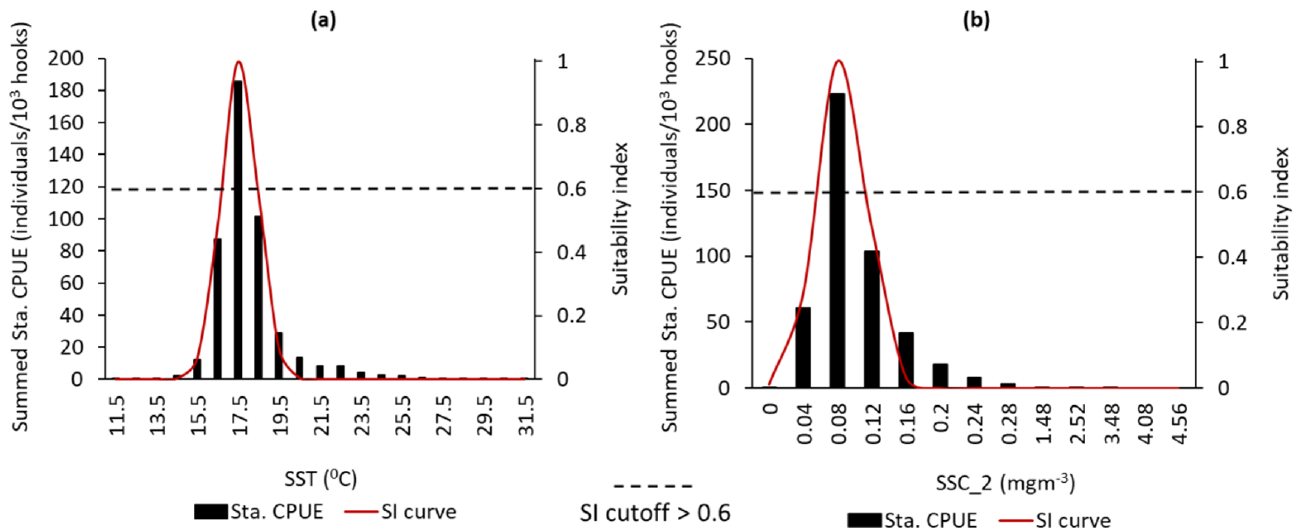
Figure 4. Suitability index (SI) curves for ( a ) SST and ( b ) SSC_2 for the SIO albacore tuna generated by using a regression method with smoothing spline. The intersection of the horizontal line and SI curve indicates the environmental variables with the optimal